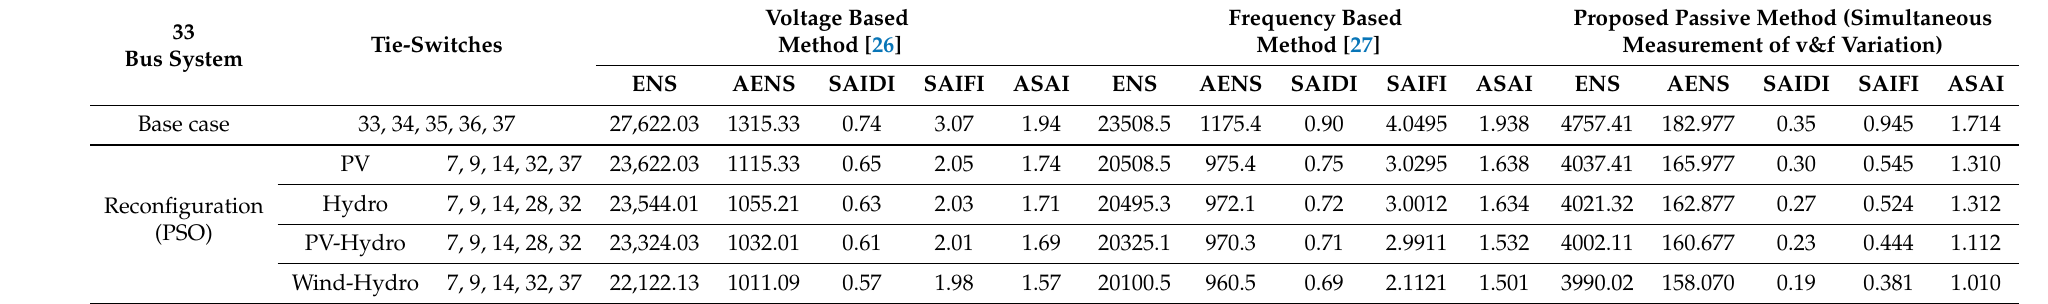
Table 7. Comparison results of reliability evaluation for 33 bus